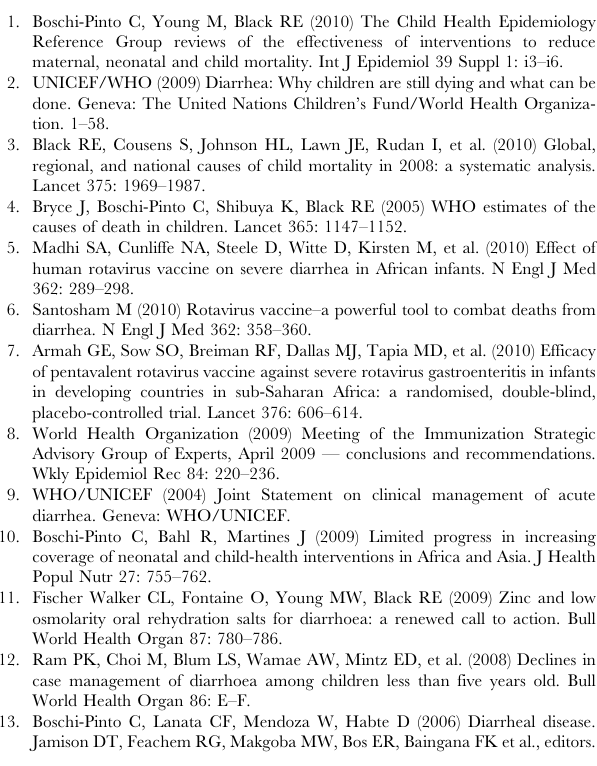
Table S1 Laboratory characterization of the enteric pathogens identified from children hospitalized with diarrhea, western Kenya 2005–2007. Table S2 Health-seeking behavior and treatments sought before hospitalization and treatments adminis- tered during hospitalization with